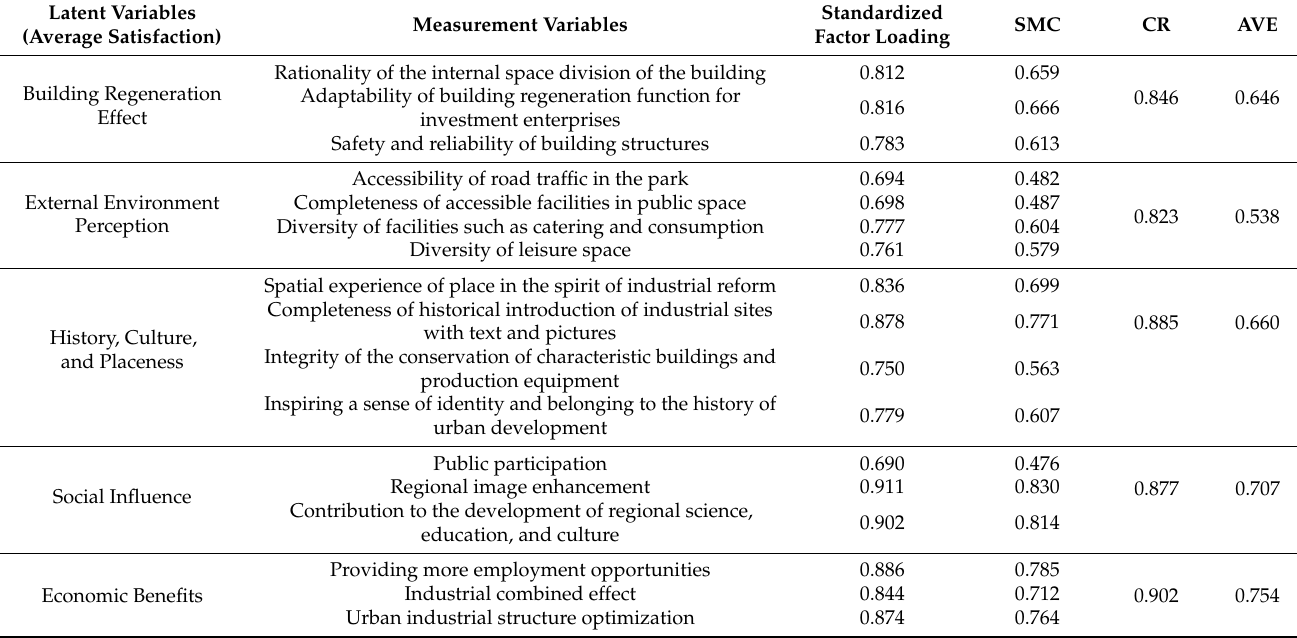
Table 3. Results of the confirmatory factor